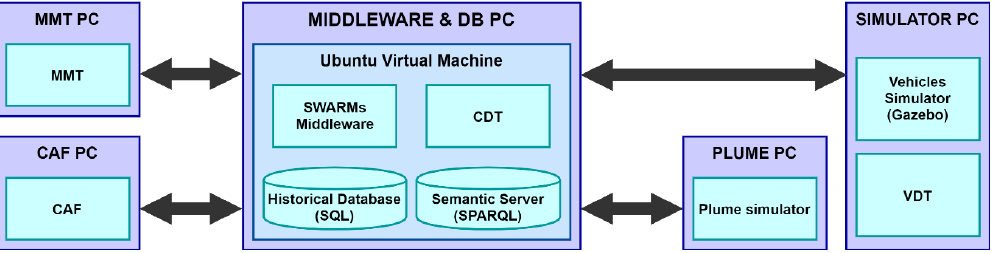
Figure 24. Distribution of the Central Control Station (CCS) computers.